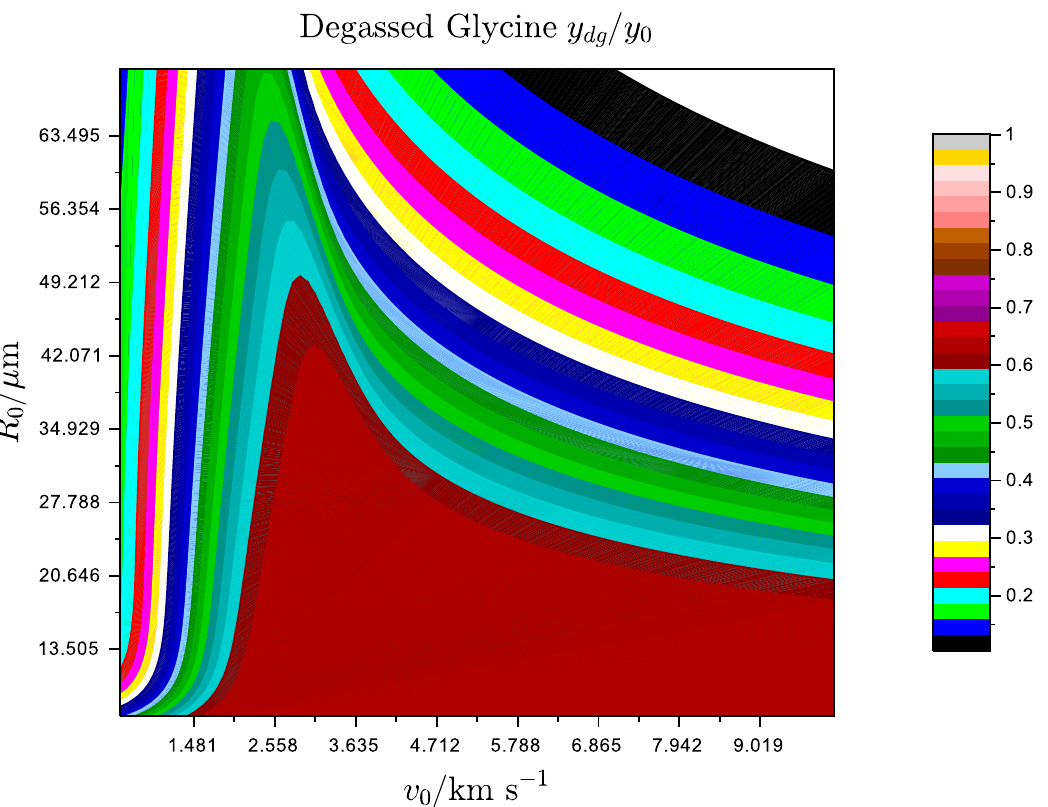
Figure 4. Contour lines of the relative concentration of surviving amino acid y / y 0 (0.07 ≤ y / y 0 ≤ 0.71) calculated with L = 3.574 × 10 − 11 m, D 0 = 1.0 × 10 − 12 m 2 s − 1 , and θ 0 = 45.0 deg versus the initial velocity and radius of micrometeoroids with 0.5 ≤ v 0 ≤ 10 km s − 1 and 7 ≤ R 0 ≤ 70 µ m.